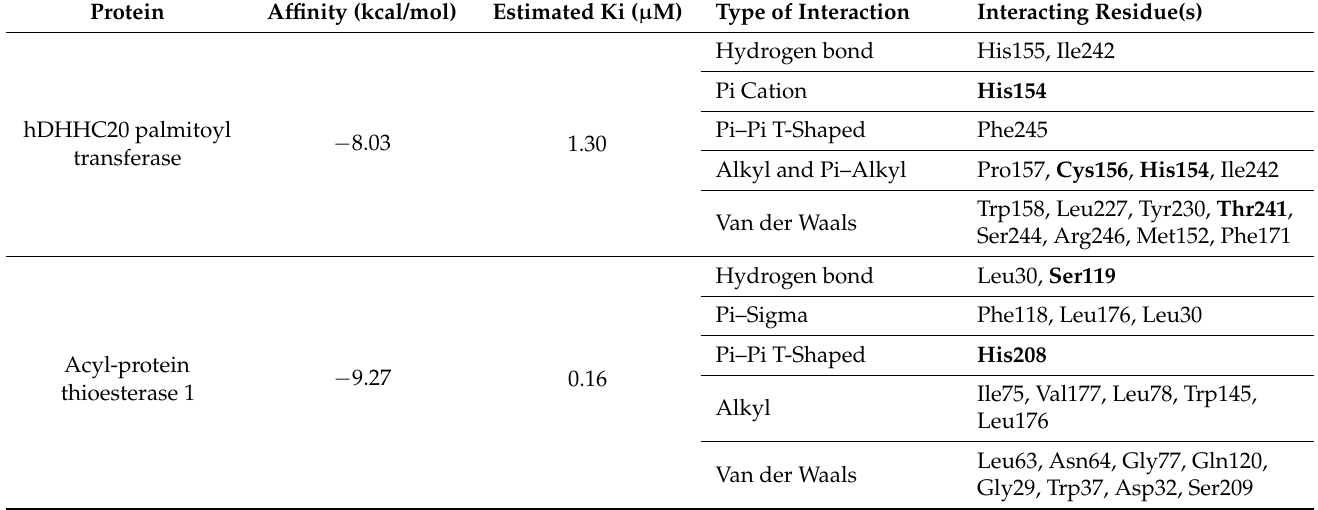
Table 1. AutoDock4 docking results of artonin F with palmitoylating